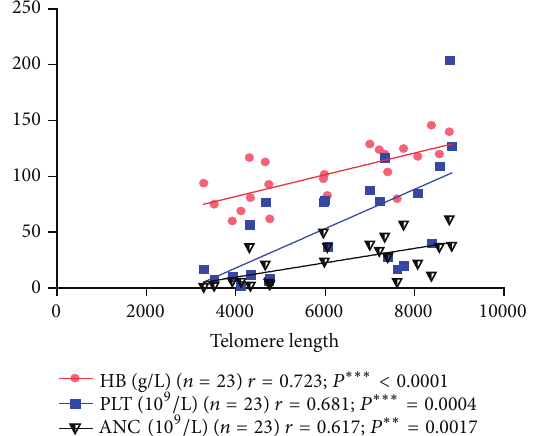
Figure 5: Normal BMMNCs cultured with SAA serum undergo a higher apoptosis rate than those cultured with